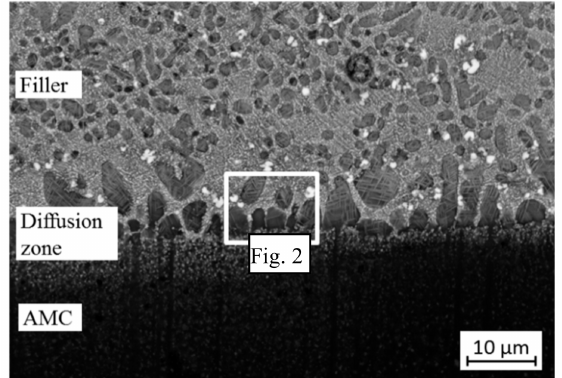
Figure 1. Microstructure (SEM) of braze filler B-Al40Ag40Cu20 wetted on AMC EN AW-2017 + 10 vol % (SiC)P, current intensity 40 A